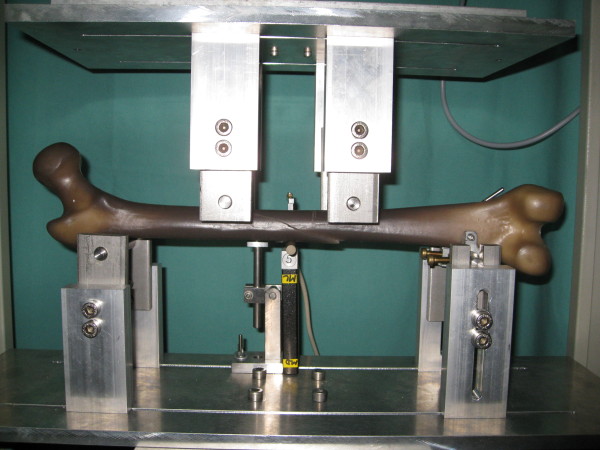
Biomechanical testing of a Sawbone® with spiral fracture in 4-point bending.